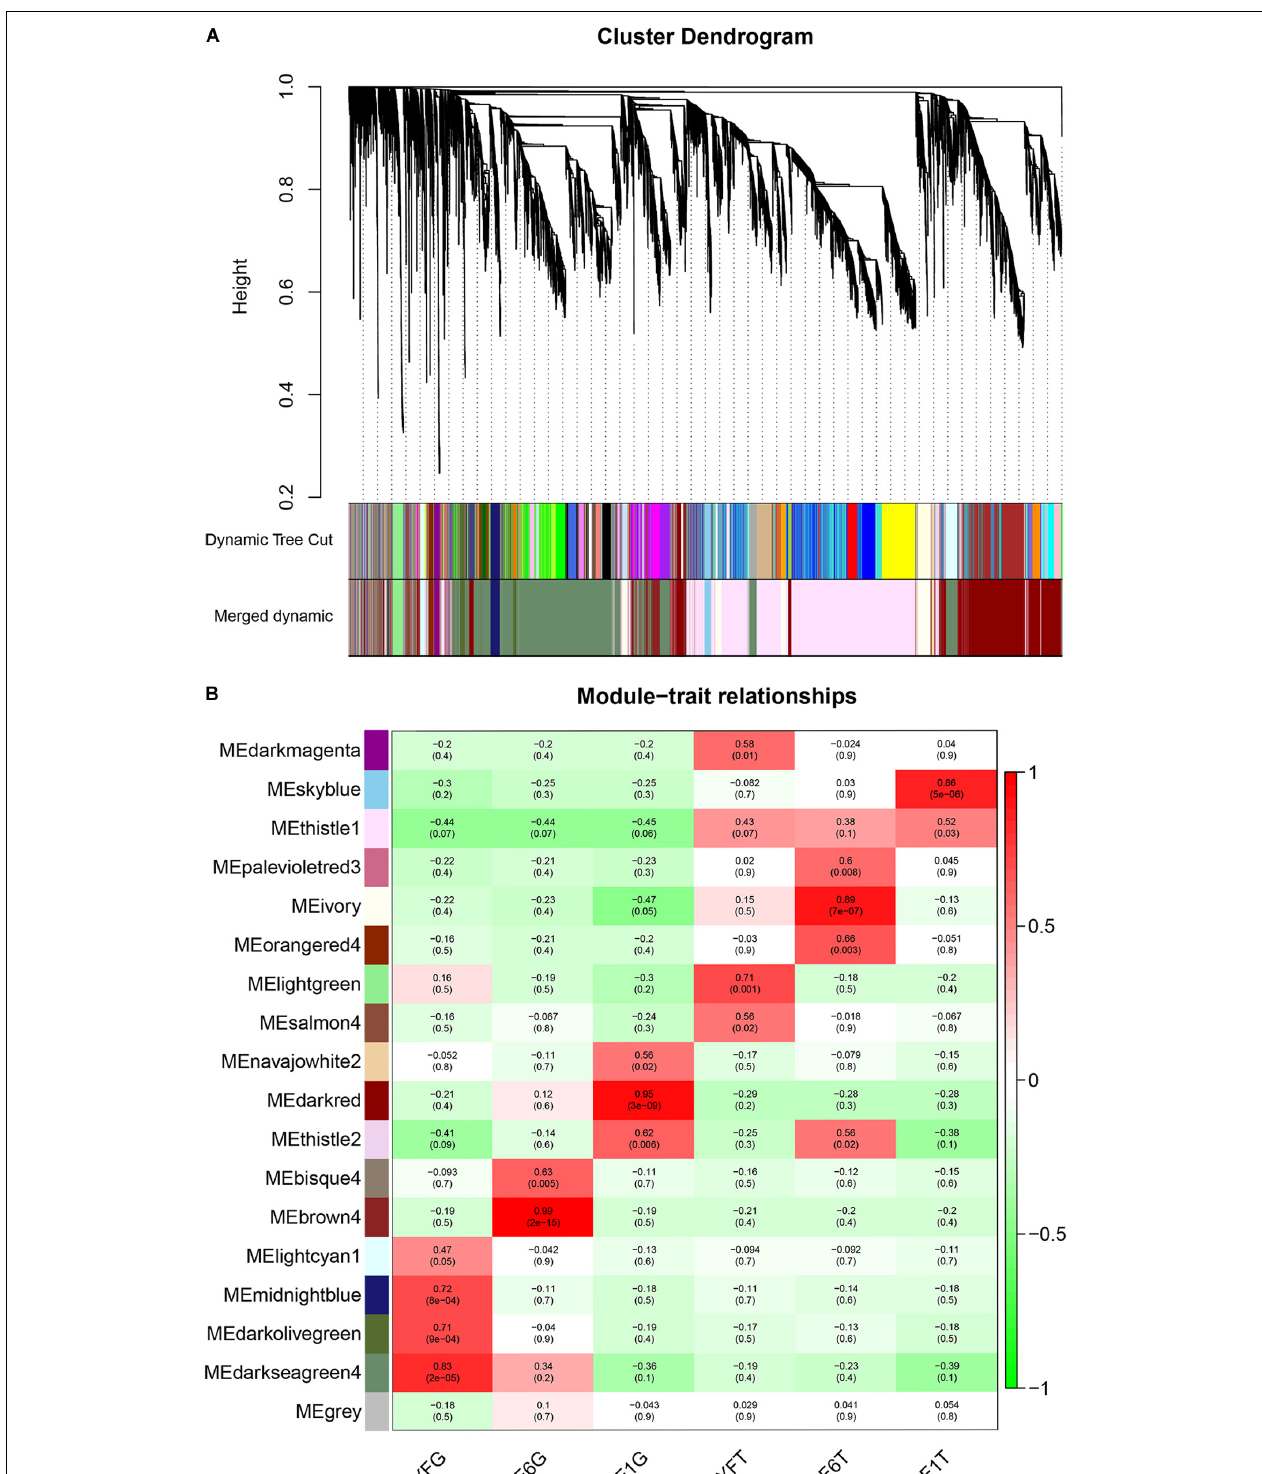
FIGURE 8 | Visualization of transcripts co-expression modules and module-trait relationships. (A) Visualization of transcripts co-expression modules, clustering dendrogram of transcripts, with dissimilarity based on topological overlap; (B) Module-stage/tissue relationships and corresponding p- values, on the left, different colors represent different modules. Each cell contains the correlation and p -value given in the parentheses. Red, positive correlation; green, negative correlation; white, none correlation. SYF, small yellow follicle; F6, the smallest hierarchical follicle; F1, the largest hierarchical follicle. G, granulosa cells; T, theca cells.